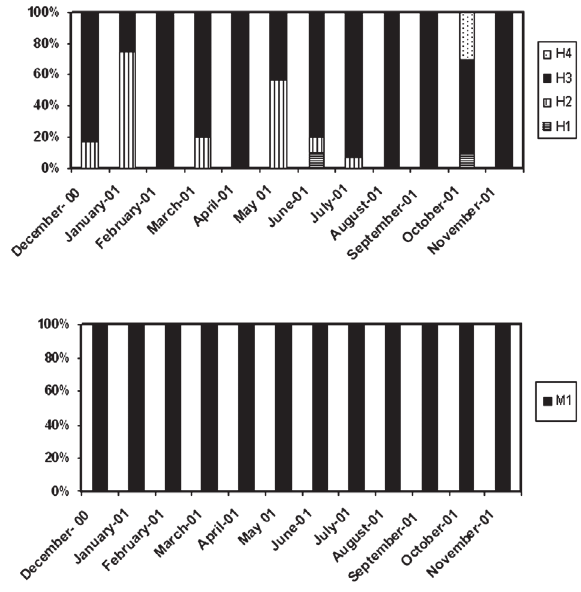
Fig . 6 . – temporal trends of the percentage for each gonadal stage at La herradura. (a) Females; h1, spent condition; h2 phase of oocyte maturation; h3, mature state with ova; h4, phase of gonadal reconstitution with maximum thickness of the nutritive layer. (B) Males; M0, spent condition; M1, mature gonad with